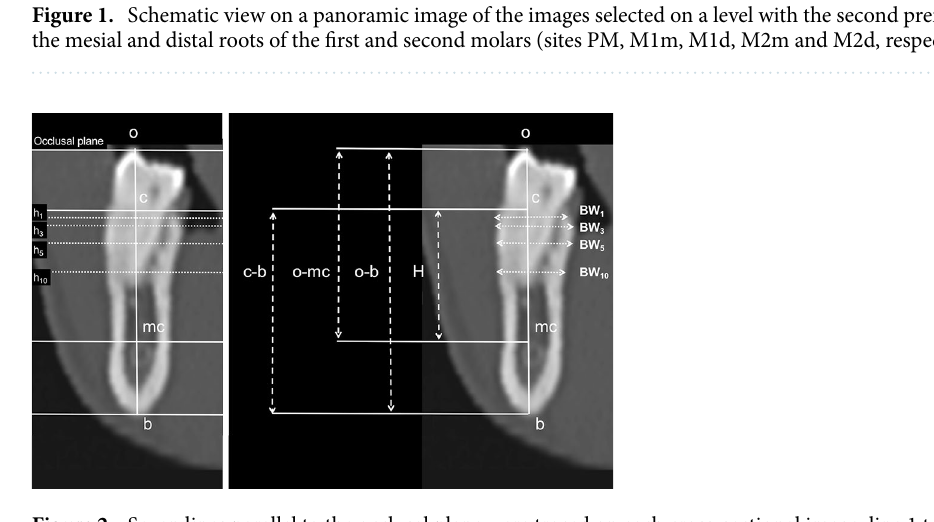
Figure 2. Seven lines parallel to the occlusal plane were traced on each cross-sectional image: line 1 touching the inferior border of the mandible (basal bone, b); line 2 at the most coronal point of the alveolar crest (crest, c); lines 3 to 6 placed at 1, 3, 5 and 10 mm apical to c (h 1 , h 3 , h 5 and h 10 , respectively); and line 7 at the most coronal point of the mandibular canal (mandibular canal, mc); and the most coronal point of the crown of the